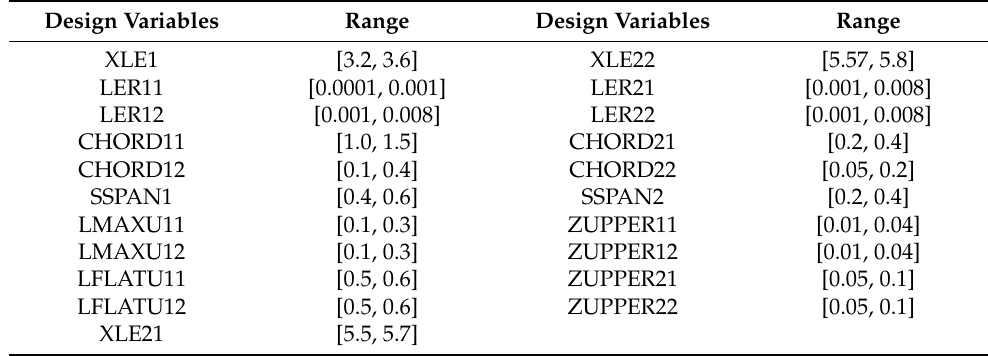
Table 5. Optimization range of design